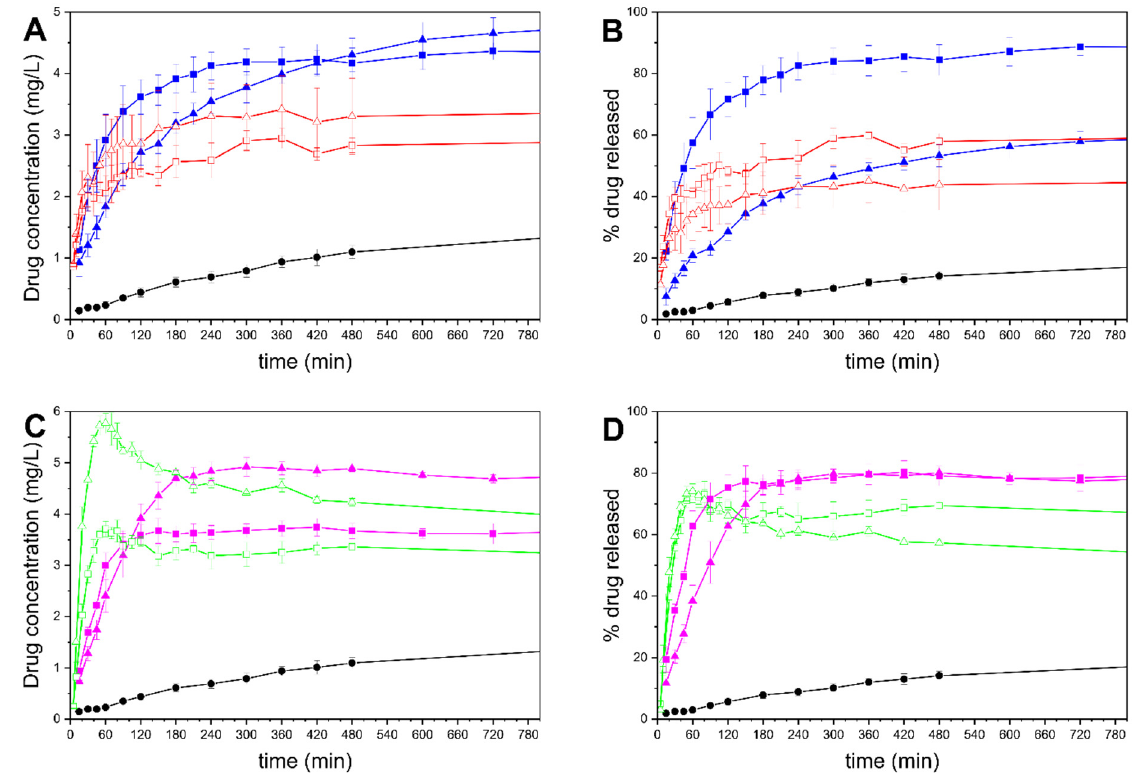
Figure 10. Drug release curves. ( A ), ( B ): MMC formulations; ( C ), ( D ): MCM-41 formulations. ( A ), ( C ): concentration of drug released over time; ( B ), ( D ): % drug released over time. Crystalline celecoxib: ● , MMC-50: □ , MMC-70: △ , MMC-T50: ■ , MMC-T70: ▲ , MCM-41-50: □ , MCM-41-70: △ , MCM-41-T50: ■ , MCM-41-T70: ▲ .